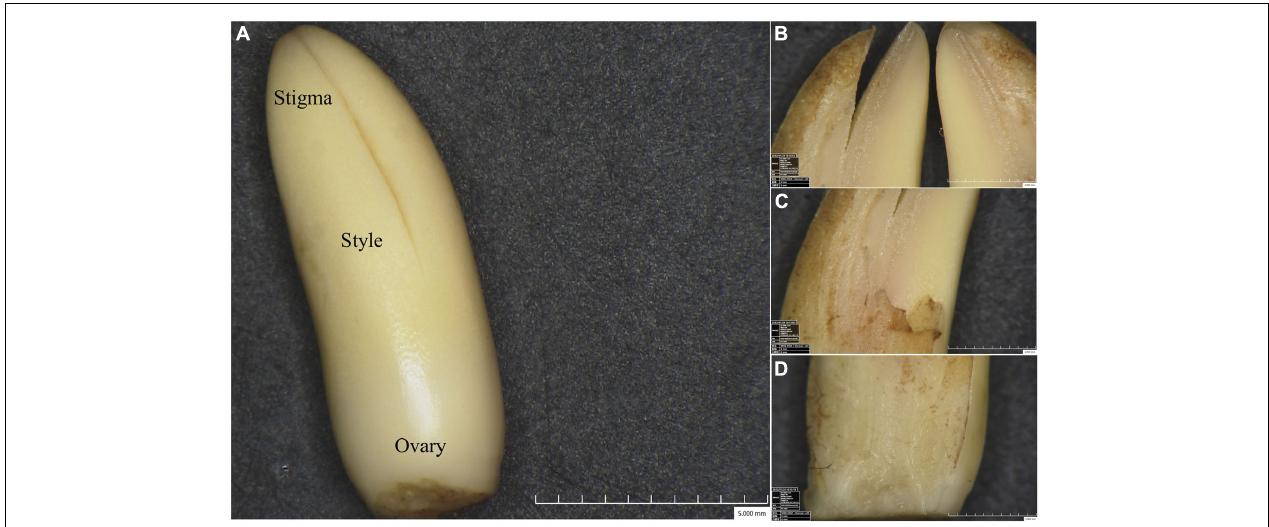
FIGURE 1 | Floral tissues viewed under digital microscope. (A) The pistil showing stigma (S), style (ST), and ovary (O). Detailed sectional views of stigma (B) , style (C) , and ovary (D)